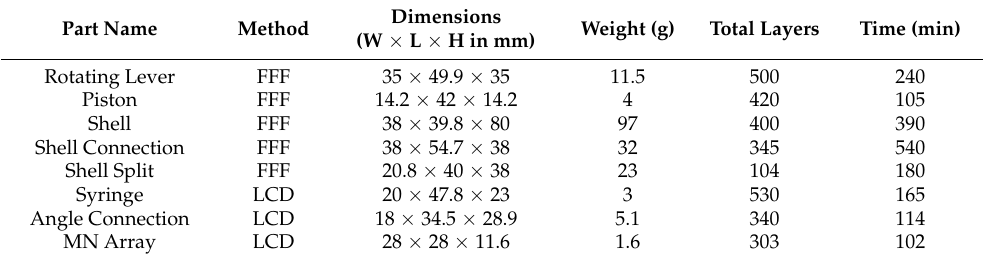
printing time for each part of the